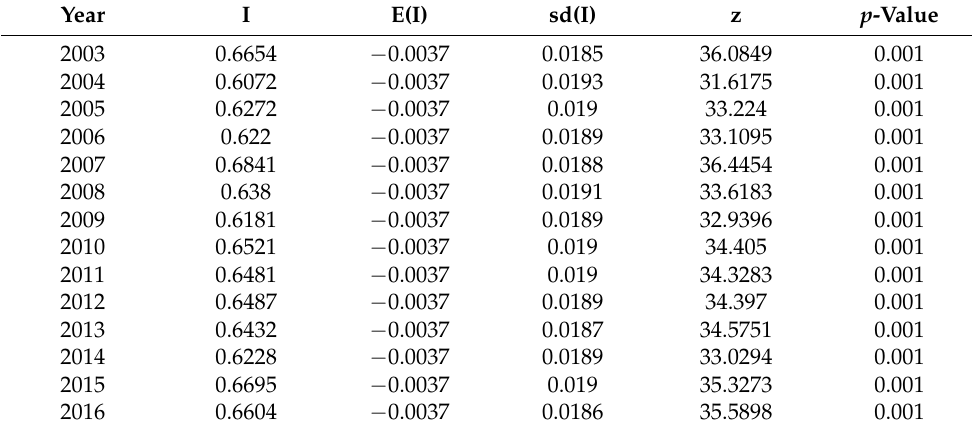
Table A1. Test results of Moran’s Index for PM2.5 concentration in 271 Chinese